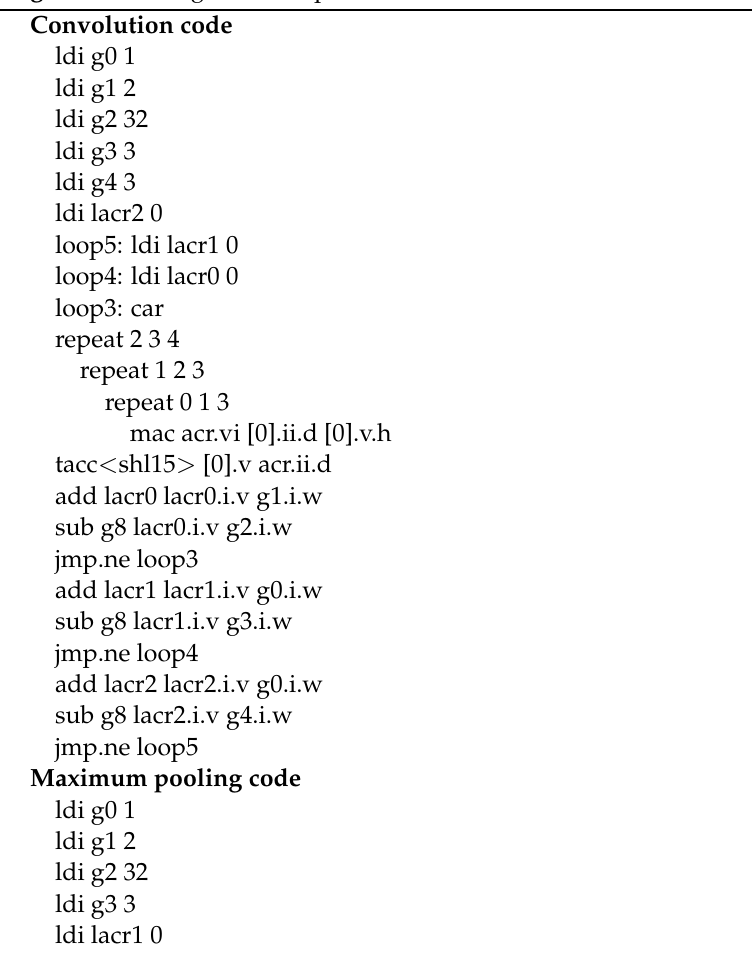
Algorithm 1: Program